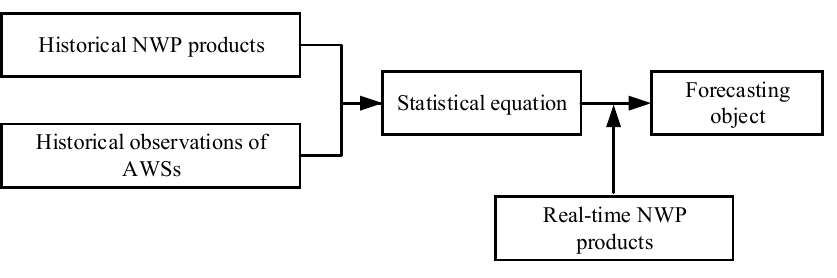
Figure 1. MOS model workflow.